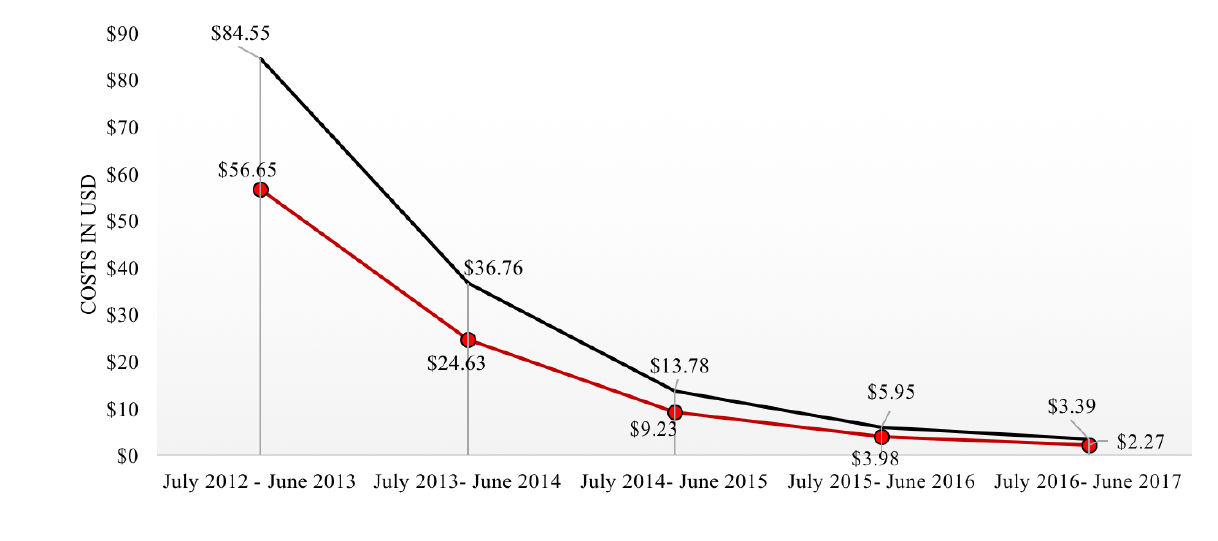
Figure 2. 5-year trends in the total program cost per registered user and per case of comprehensive care (CC) received among MAMA users over 60